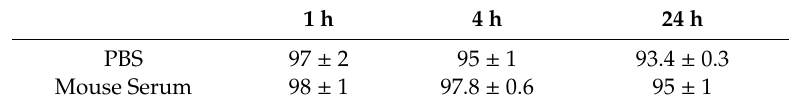
Table 1. Stability of [ 55 Co]Co-cm10 in PBS and mouse serum a